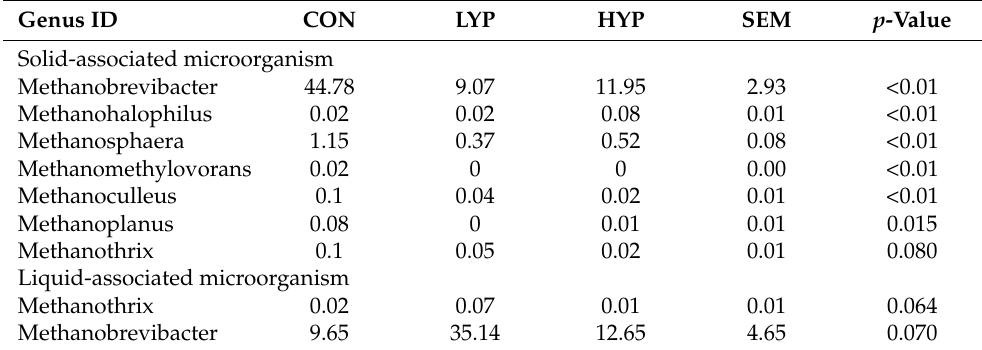
Table 4. Effect of yeast product on methanogens in sheep rumens. Genus